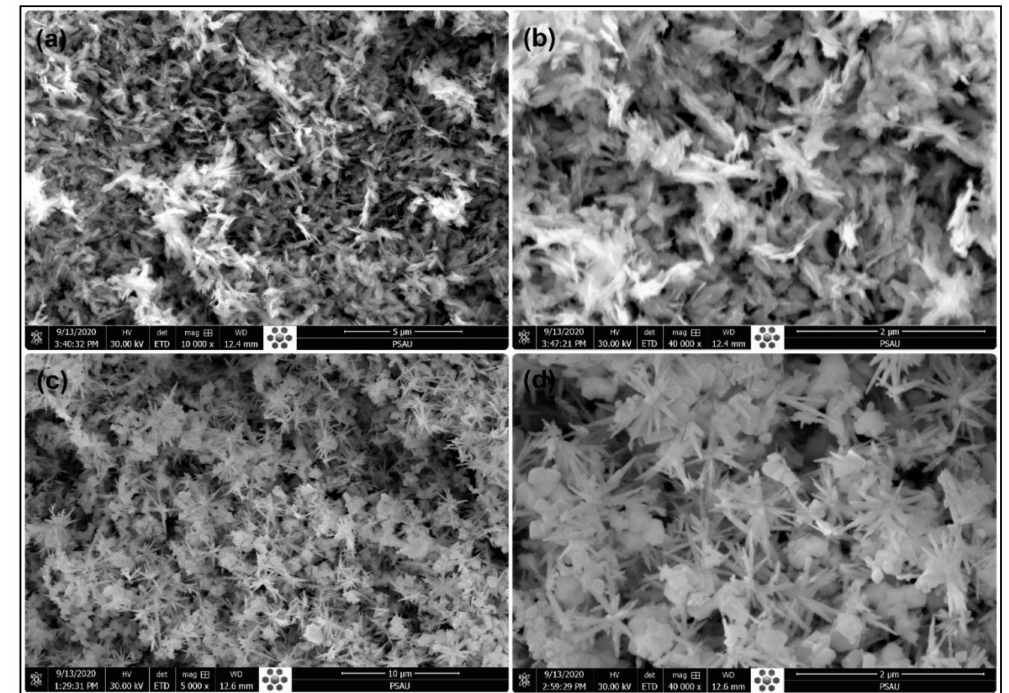
Figure 1. FE-SEM micrographs of the ( a , b ) pure copper oxide and ( c , d ) shows the micrographs of Zinc (Zn)-doped Copper oxide (Zn-doped